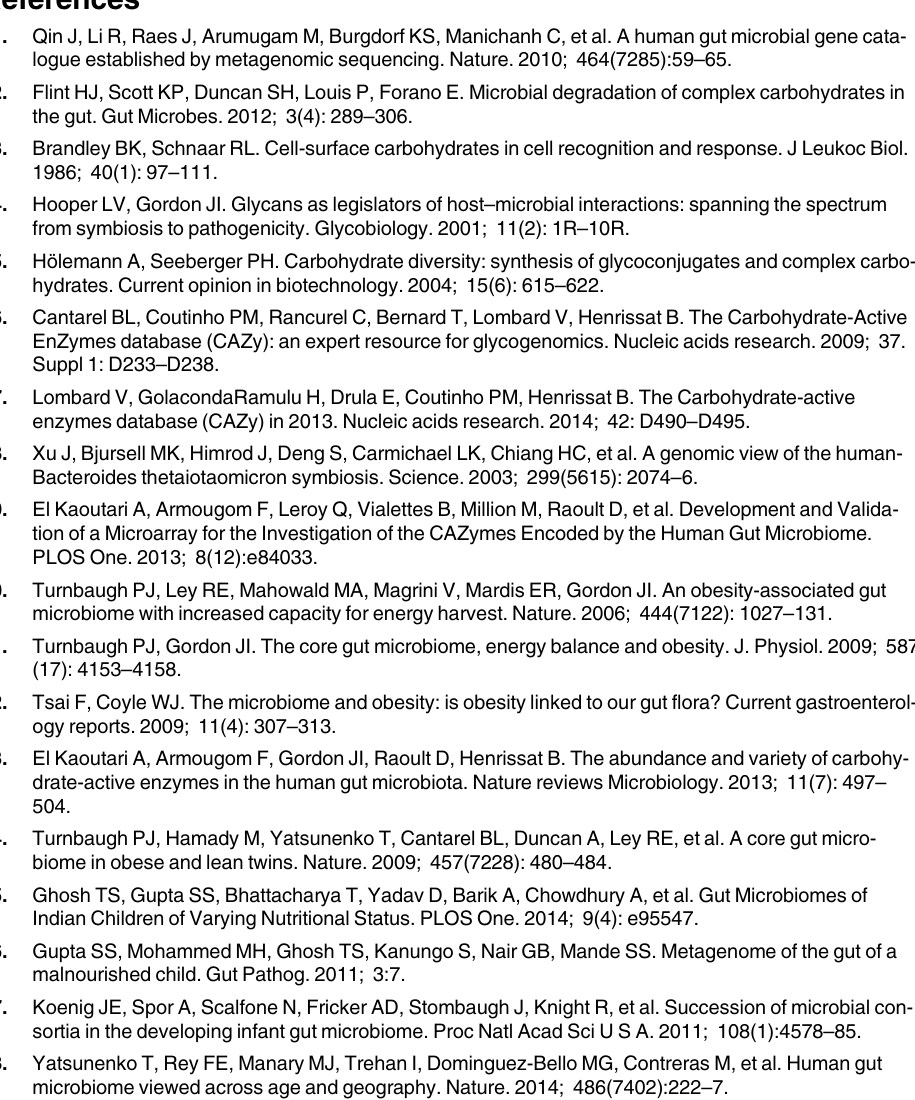
S5 Table. CAZotype affiliation of 448 metagenomic